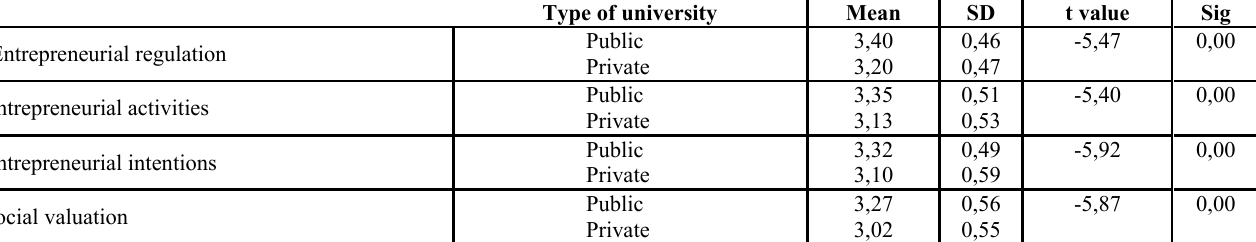
Table 2: t-test results for students’ self-regulation, self-efficacy and intention based on type of